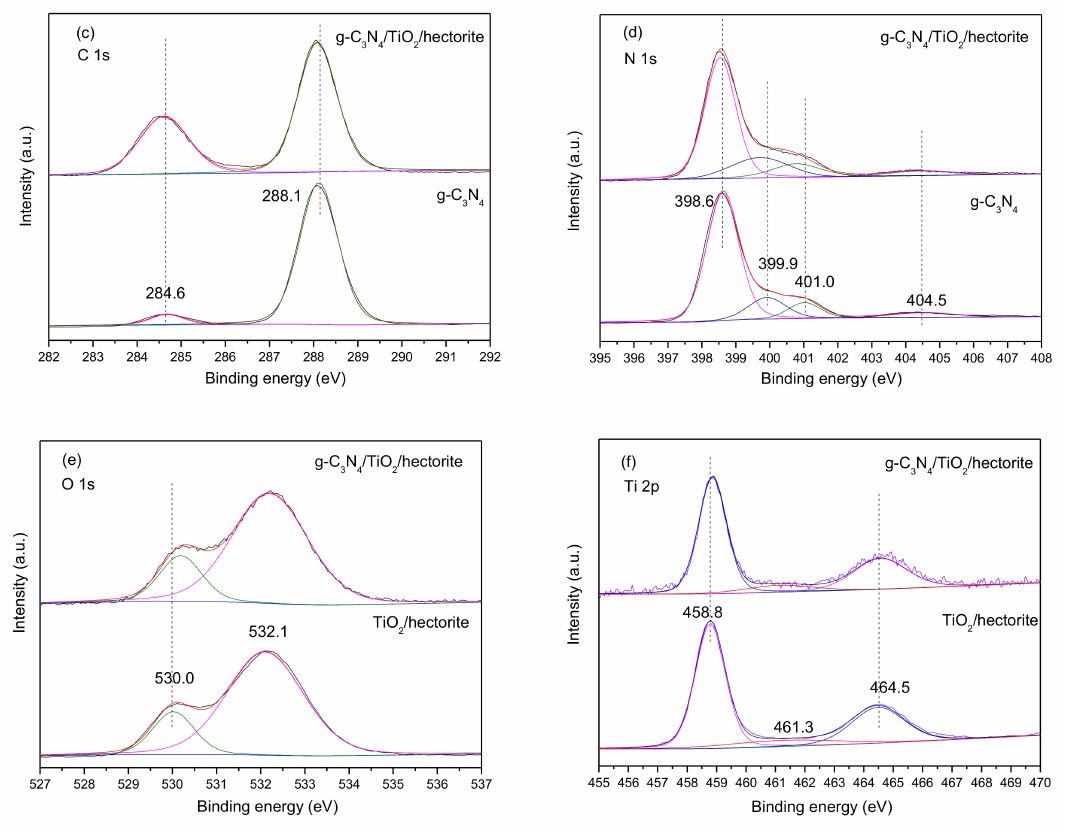
Figure 6. X-ray photoelectron spectroscopy (XPS) spectra of TiO 2 / hectorite, g-C 3 N 4 and g-C 3 N 4 / TiO 2 / hectorite composite sample: ( a ) is survey spectrum; ( b ) is F 1s; ( c ) is C 1s; ( d ) is N 1s; ( e ) is O 1s; ( f ) is Ti